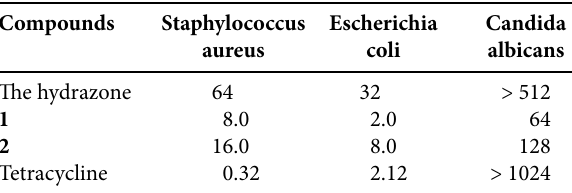
Table 4. MIC values (μg/mL) for the antimicrobial activities of the tested compounds Compounds Staphylococcus Escherichia Candida aureus coli albicans The hydrazone 64 32 > 512 1 8.0 2.0 64 2 16.0 8.0 128 Tetracycline 0.32 2.12 >